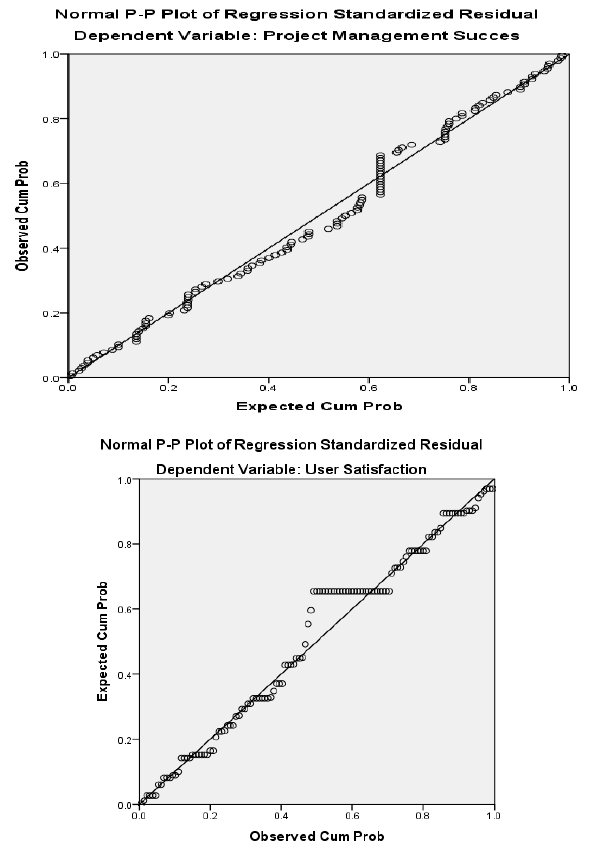
Figure 5. Normal (P-P) plot of regression standardized residual.